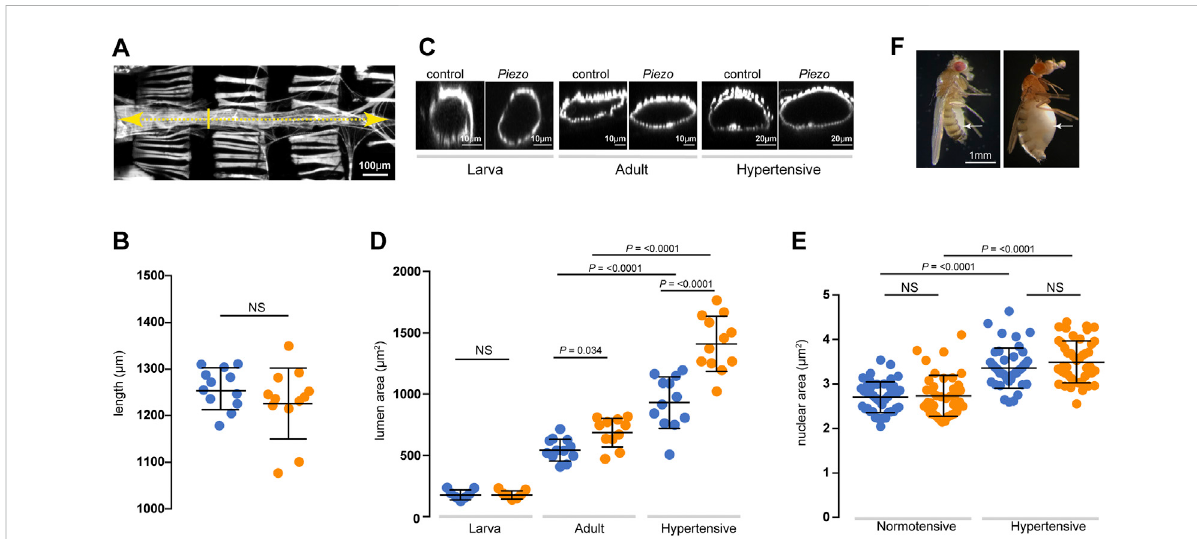
FIGURE 5 Dilationoftheheartlumen in Piezo KO . (A) Adult heartstainedwith phalloidin toreveal morphology. Heartlength(yellow dashedline)andlumen cross-sectional area at the position of the 2 nd abdominal segment (yellow solid line) were measured. Anterior is to left. (B) Heart length of control (blue) and Piezo KO (orange) adult hearts ( n = 12; n = 12). (C) Optical x-z projection of control or Piezo KO hearts stained with phalloidin from fi rst instar larva (left), 3-day old adult (middle) and 10-day old hypertensive adult (right). (D) Lumenal area in control (blue) and Piezo KO (orange) hearts for fi rst instarlarvae( n = 7; n = 7),normotensive adults( n = 12; n = 11) and hypertensiveadults ( n = 12; n =12). (E) Cardiomyocyte nuclear area incontrol (blue) and Piezo KO (orange) adult hearts under normotensive ( n = 42; n = 45) and hypertensive conditions ( n = 43; n = 41) n = number of cardiomyocytesfromatleast3individualhearts. (F) Control(left)and10-dayoldhypertensiveadult(right);inthehypertensive fl ytheheartisexposed to high blood pressure in the grossly swollen haemolymph- fi lled abdomen (white arrow indicates swollen abdomen). p -values, unpaired